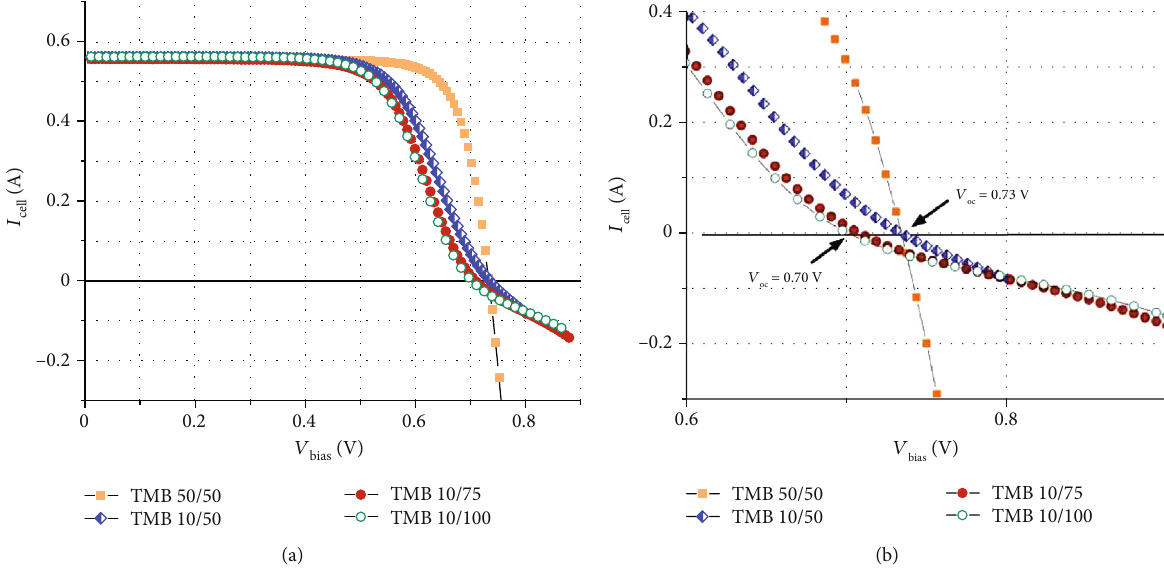
Figure 10: Light I-V characteristics of typical cells from the four di ff erent sample splits as described in Table 4. Panel (b) shows an expanded view close to the V point of the same curves in (a). The arrows indicate the shift in the value of V OC